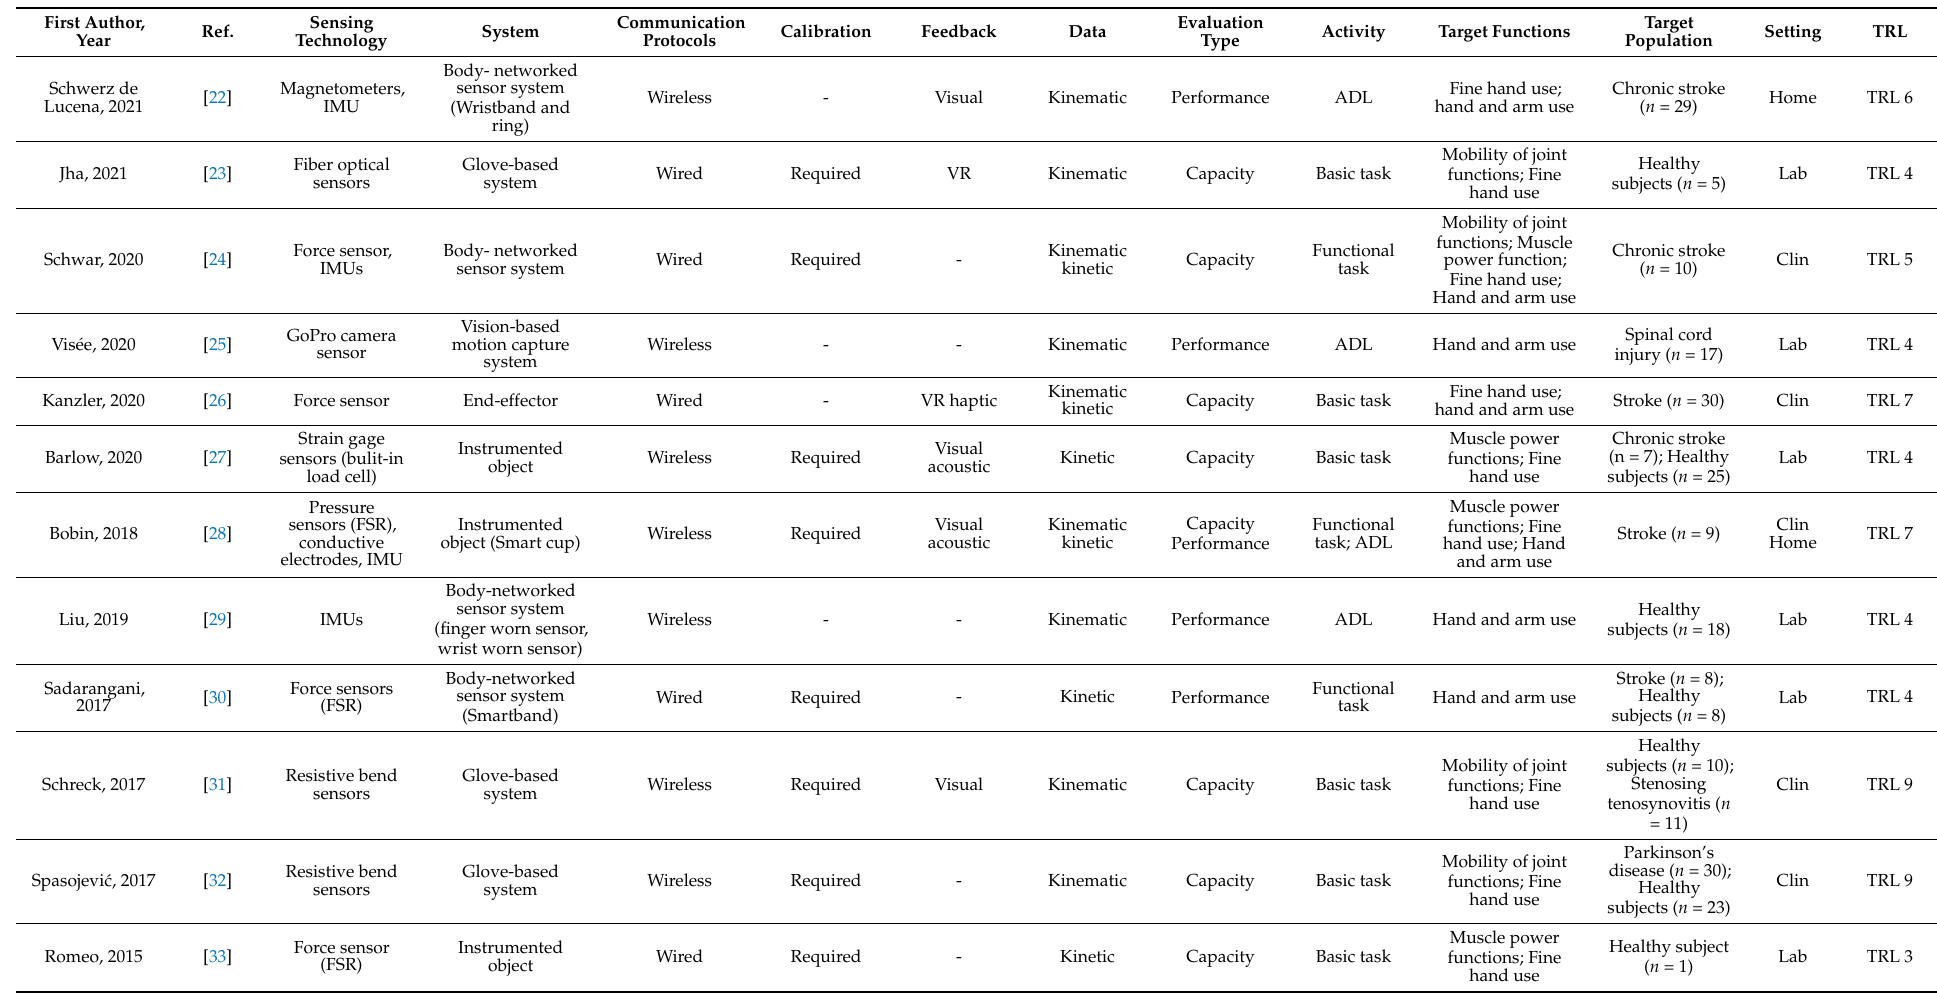
Table 2. Summary of the paper lists and features. Ref. = reference, TRL = technology readiness level, IMU = inertial measurement unit, ADL = activities of